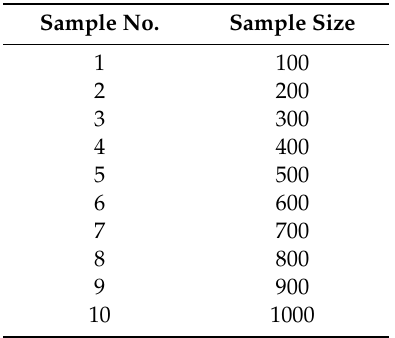
Table 4. Samples used in assessing the DT accuracy based on an increasing sample